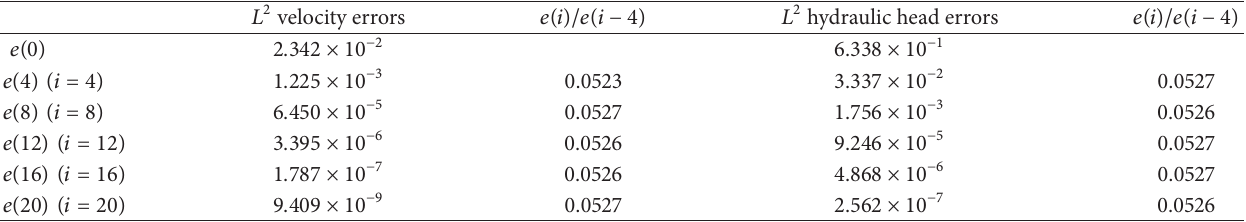
Figure 5: Geometric convergence rate of the pressure of the free flow (a) and 𝜂 𝑓 (b) versus the iteration counter 𝑚 for the parallel DDM with BJS interface condition. Table 2: 𝐿 2 errors in velocity and hydraulic head for the parallel DDM with BJS interface condition.